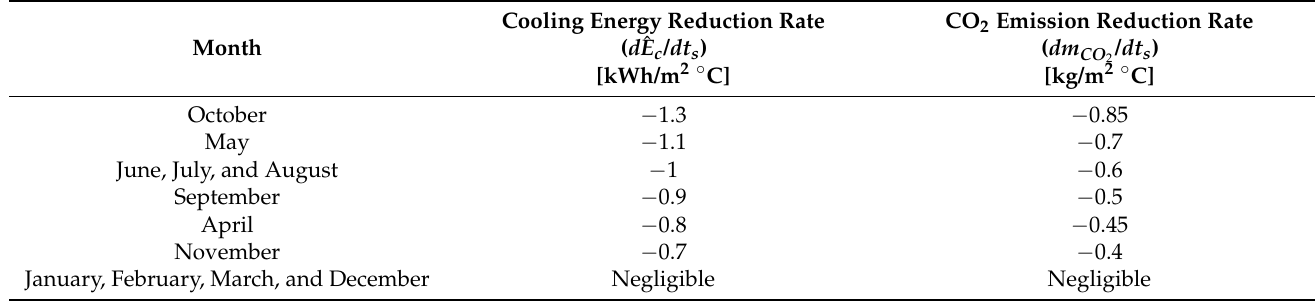
Table 4. The monthly effects of increasing the cooling setpoint temperature by 1 ◦